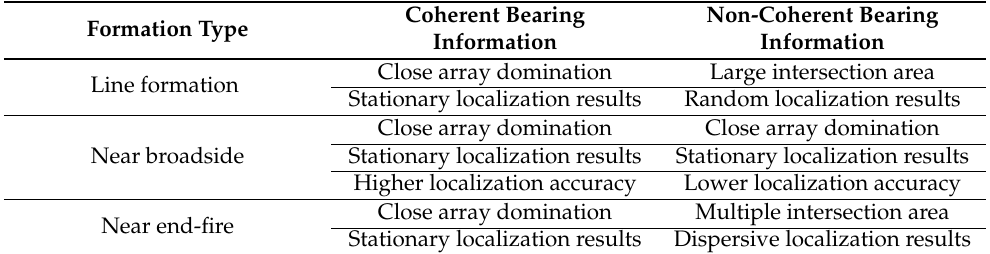
Table 1. Comparison of the DPD processors with three